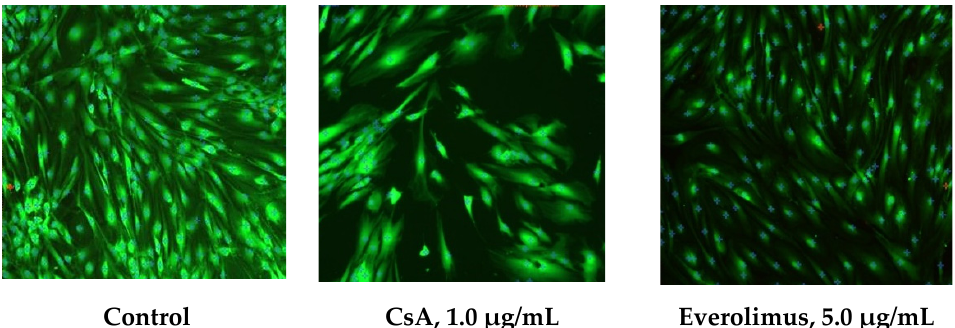
Figure 8. Fluorescence microscopy of HTFs cultures. Day seven. Stain: Live/Dead Cell-Mediated Cytotoxicity Kit. Magnification × 100. Calculation of damaged and viable cells using software CellSens Standart 1.7.